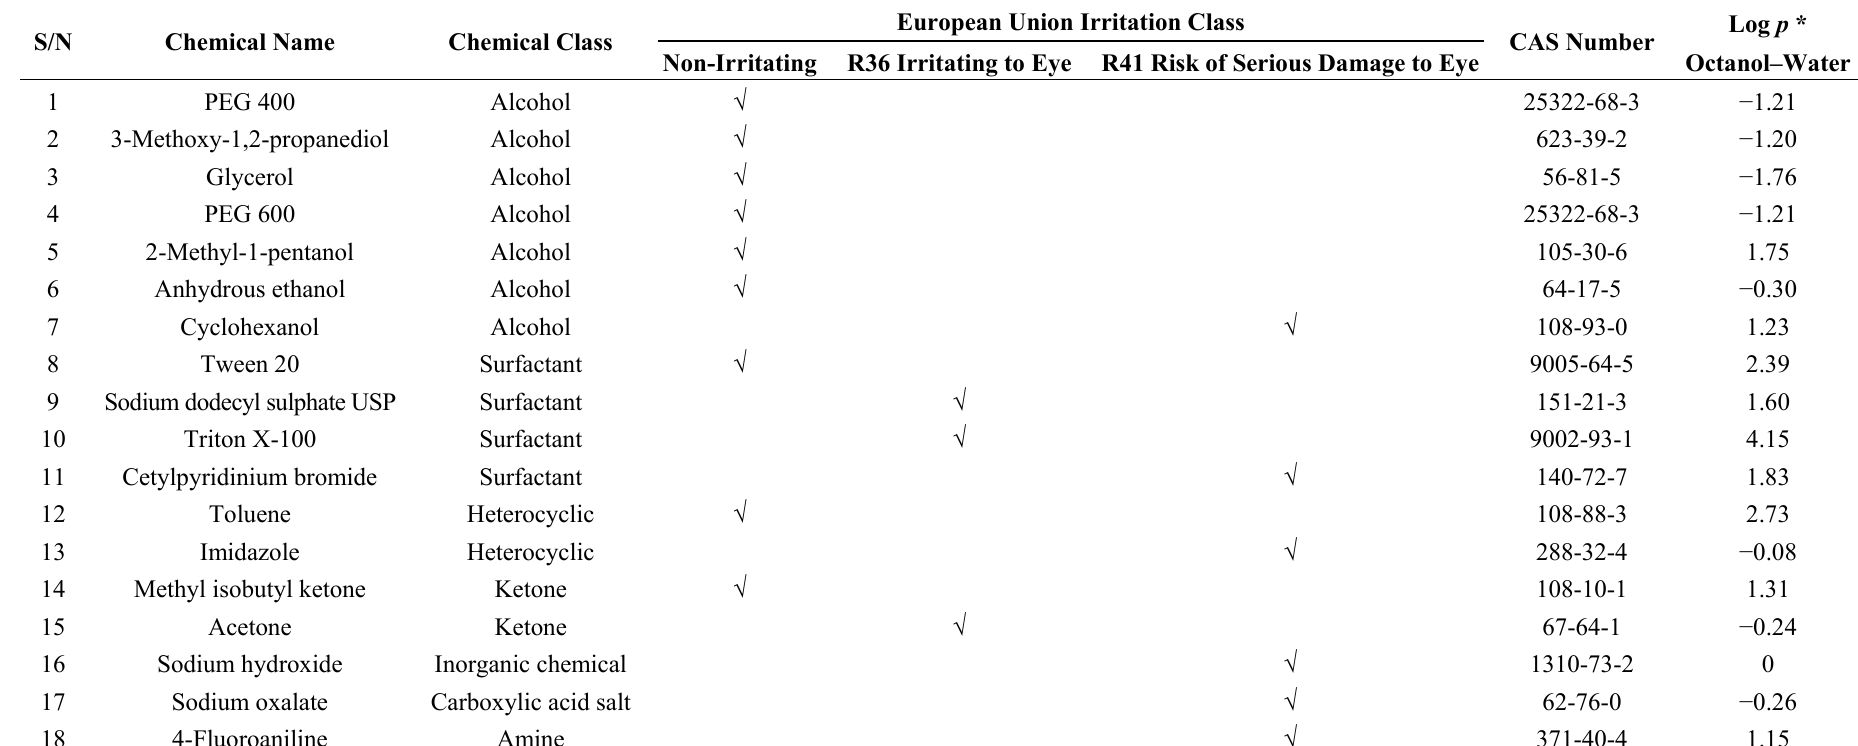
Table 1. Compounds used for toxicity